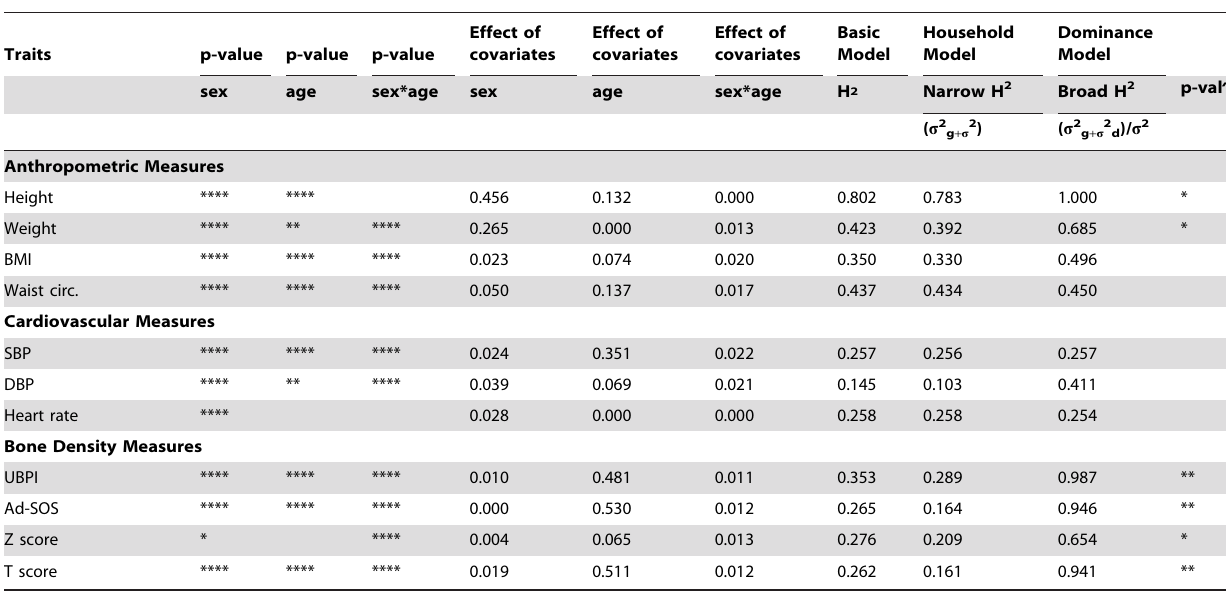
Table 2. Heritability of anthropometric, cardiovascular and bone status QUS parameters.